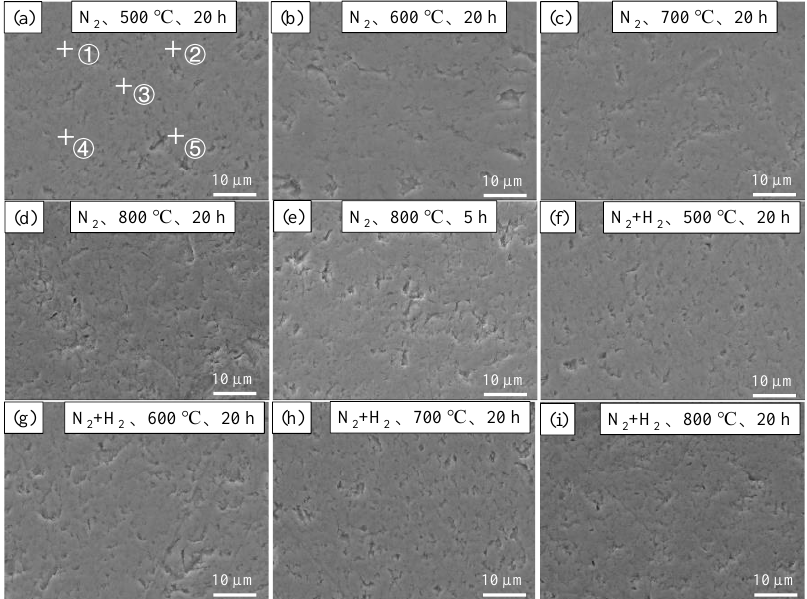
Figure 2. Surface SEM images of zirconium hydride with nitride film ( a ) N 2 , 20 h, 500 °C; ( b ) N 2 , 20 h, 600 °C; ( c ) N 2 , 20 h, 700 °C; ( d ) N 2 , 20 h, 800 °C; ( e ) N 2 , 5 h, 800 °C; ( f ) N 2 + H 2 , 20 h, 500 °C; ( g ) N 2 + H 2 , 20 h, 600 °C; ( h ) N 2 + H 2 , 20 h, 700 °C; ( i ) N 2 + H 2 , 20 h, 800 °C .